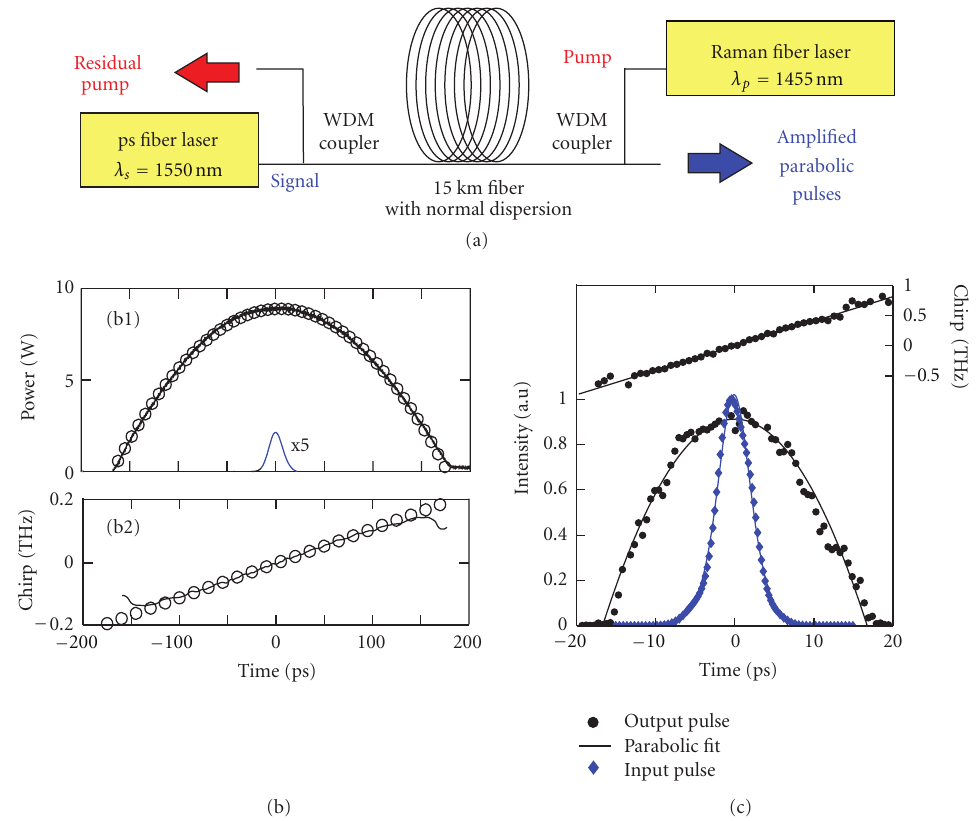
Figure 2: (a) Experimental setup for parabolic pulse generation through Raman amplification at telecommunication wavelengths. (b) Results obtained in the Raman amplifier (adapted from [54]): temporal intensity profile (subplot b1) and chirp profile (subplot b2) of the output pulse from the amplifier. The experimental results (solid black lines) are compared to a parabolic and a linear fit (open black circles), respectively. The intensity profile of the initial pulse is also shown (solid blue line). (c) Results obtained in a ND decreasing fibre (adapted from [55]): experimental temporal intensity and chirp profiles at the fibre output (black circles) compared to a parabolic and a linear fit (solid black lines), respectively. The initial intensity profile is also shown (blue